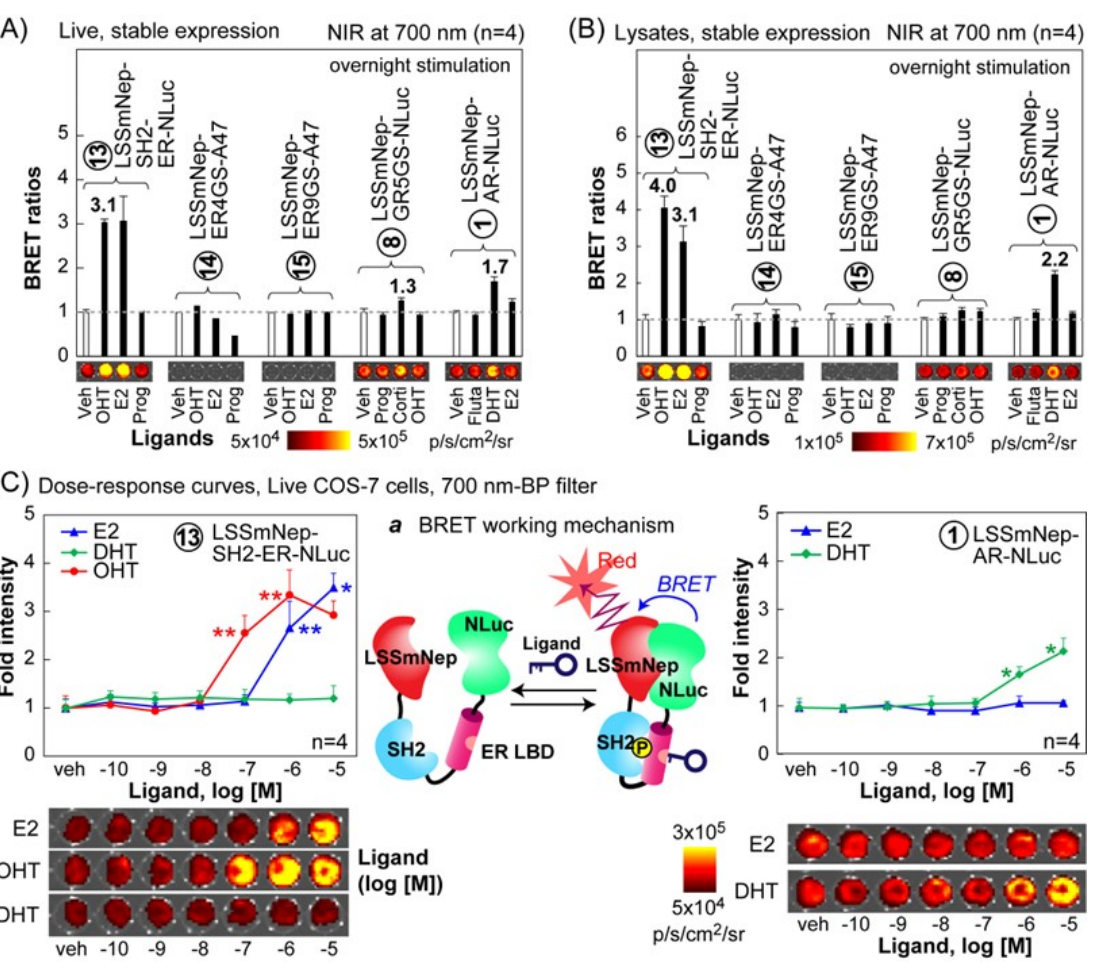
Figure 6. Ligand specificity of selected NIR BL imaging probes stably expressed in mammalian cells. ( A ) NIR BL intensities of the selected imaging probes in live cells after stimulation using various steroid hormones. ( B ) NIR BL intensities of the selected imaging probes in the lysates after stimulation using various steroid hormones. ( C ) Dose–response curves of LSSmNep-SH2-ER-NLuc (left) and LSSmNep-AR-NLuc (right) after stimulation of varying concentrations of steroid hormones. Inset ‘ a’ illustrates the working mechanism of LSSmNep-SH2-ER-NLuc. Ligand-activated ER LBD is phosphorylated and recognized by the adjacent SH2 domain. The fold-up structure exerts enhanced NIR BL intensities. The p-values (student’s t -test) are ** < 0.01 and * < 0.1, respectively. A similar ligand specificity of the probes was observed even in the lysates (Figure 6B). The LSSmNep-SH2-ER-NLuc in lysate showed a 4.0-fold and 3.1-fold elevation in the NIR-BRET ratios with OHT and E2, respectively. The LSSmNep-AR-NLuc in lysate also shows 2.2-fold enhanced NIR-BRET ratios only with the agonist DHT. The same probe